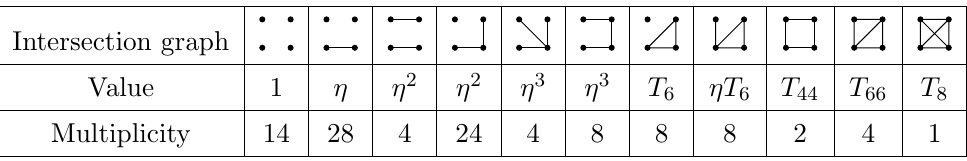
Table 3 . All the intersection graphs for the eighth